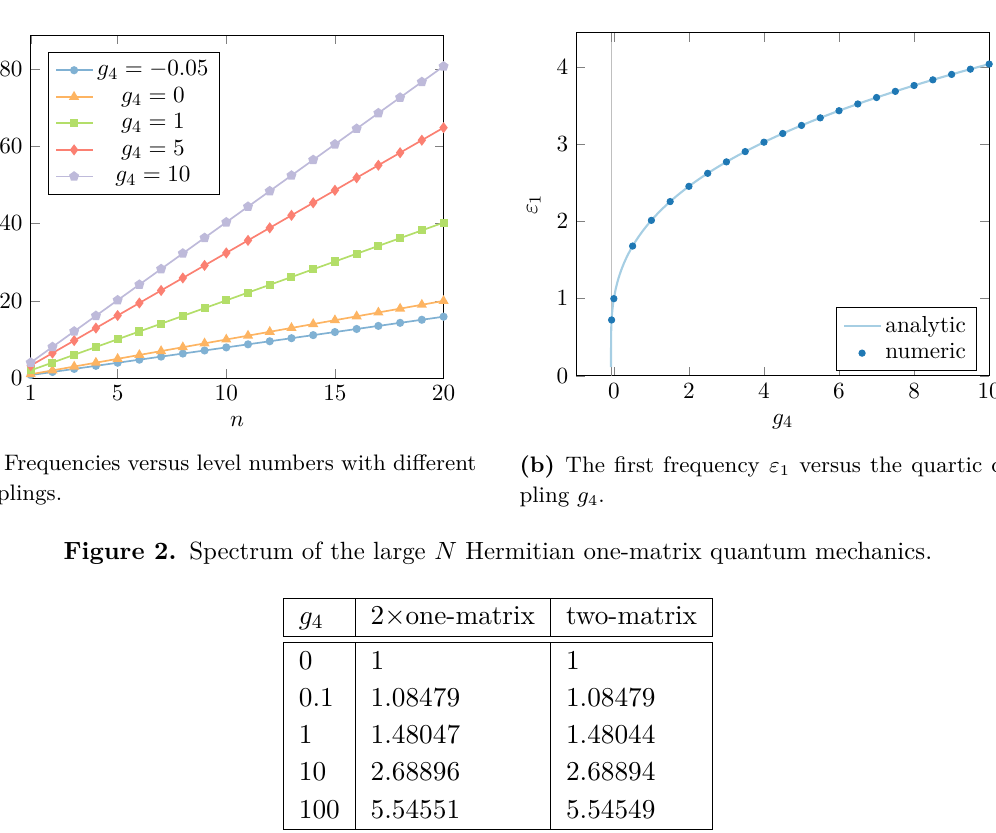
Table 12. E (0) gs